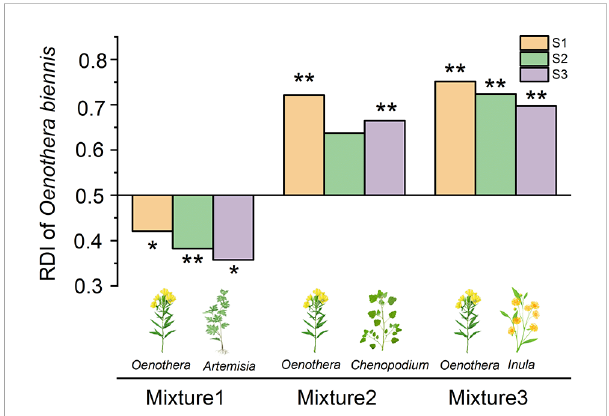
FIGURE 1 Relative dominance index (RDI) of Oenothera biennis in mixtures at three salinity treatments. Oenothera biennis in mixed culture with Artemisia argyi (Mixture1), Chenopodium album (Mixture2), and Inula japonica (Mixture3). Values are presented as 0.5 ± SE ( n = 10 for all treatments). Signi fi cant effects are indicated by asterisks: ** p ≤ 0.01 and * p ≤